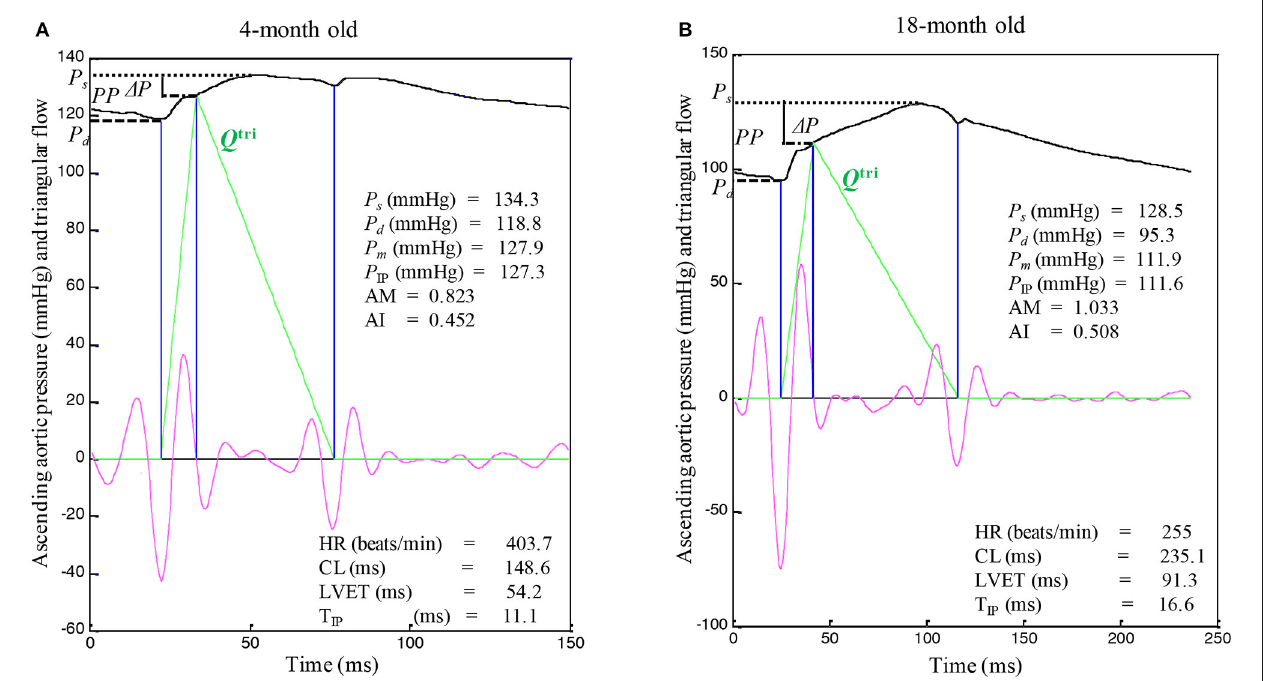
FIGURE 3 | An uncalibrated triangular flow ( Q tri ) derived from the measured aortic pressure wave in rats aged 4 (A) and 18 months (B) . The 4-month old rat is the same one as shown in Figure 1 . Only the pressure signal was recorded in the ascending aorta under the anesthetized, closed-chest condition. AM, augmentation magnitude, given by 1 P /( PP − 1 P ); AI, augmentation index, given by 1 P / PP ; CL, cardiac cycle length; HR, basal heart rate; LVET, left ventricular ejection time; P s , systolic pressure; P d , diastolic pressure; P m , mean aortic pressure; PP , pulse pressure; P IP , pressure at inflection point; 1 P , given by P s − P IP ; T IP , time to inflection